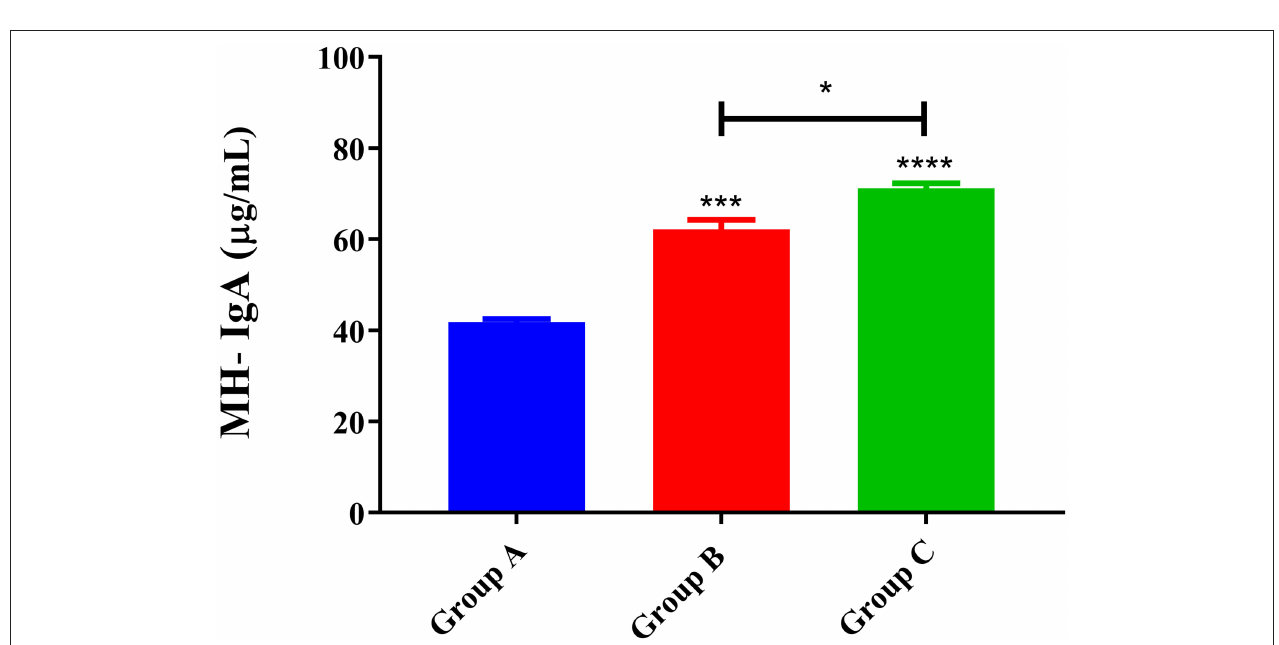
FIGURE 2 | MH-IgA contents of abomasum measured in trial 1. Group A, unchallenged goats; Group B, goats challenged with L3s at day 1; Group C, goats challenged with L3s at day 1 and then immunized by PcAb-rHc8 antibodies at days 2 and 3 post-challenge. Data are expressed as mean ± SEM. *** p < 0.001, **** p < 0.0001 vs. blank group and a capped line designates two groups that differ significantly (* p <